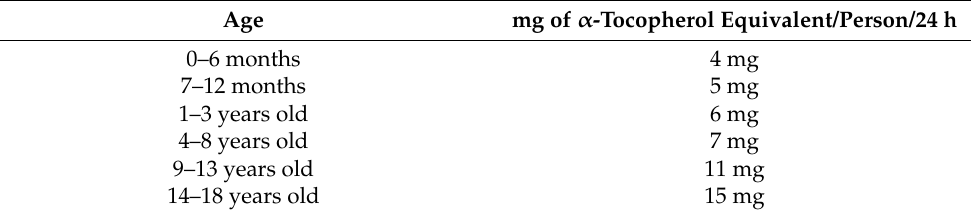
Table A2. Recommended Vitamin E Intake for Children (RDA).